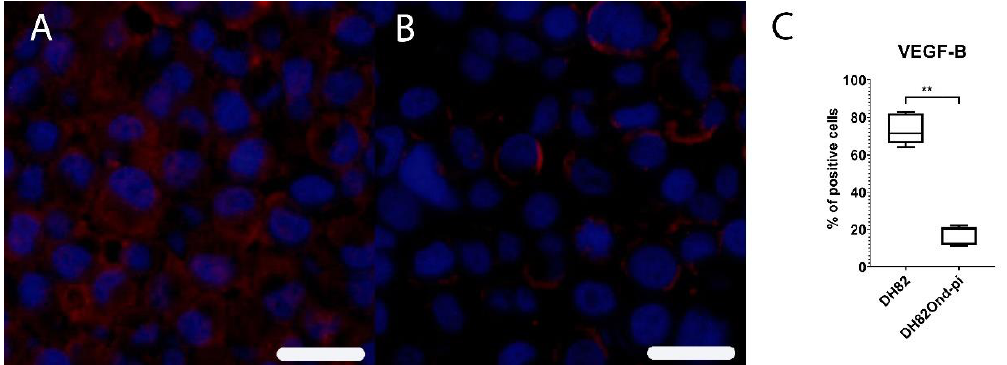
Figure 7. Immunofluorescence analysis for vascular endothelial growth factor B (VEGF-B, Cy3, red) revealed a high expression of this marker in non-infected DH82 cells ( A ), whereas a low expression was present in persistently canine distemper virus (CDV)-infected DH82 cells ( B ); Bar = 20 µm. This statistically significant difference is graphically shown in ( C ). Box and whisker plots display median and quartiles with maximum and minimum values. Significant differences ( p ≤ 0.05, Mann–Whitney U-test) are labeled by asterisks (** p ≤ 0.01).